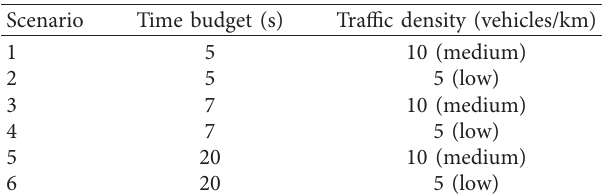
Figure 2: Automated driving function icons: (a) available, (b) active, and (c) takeover. Table 1: Scenario composition of the conditions time budget and traffic